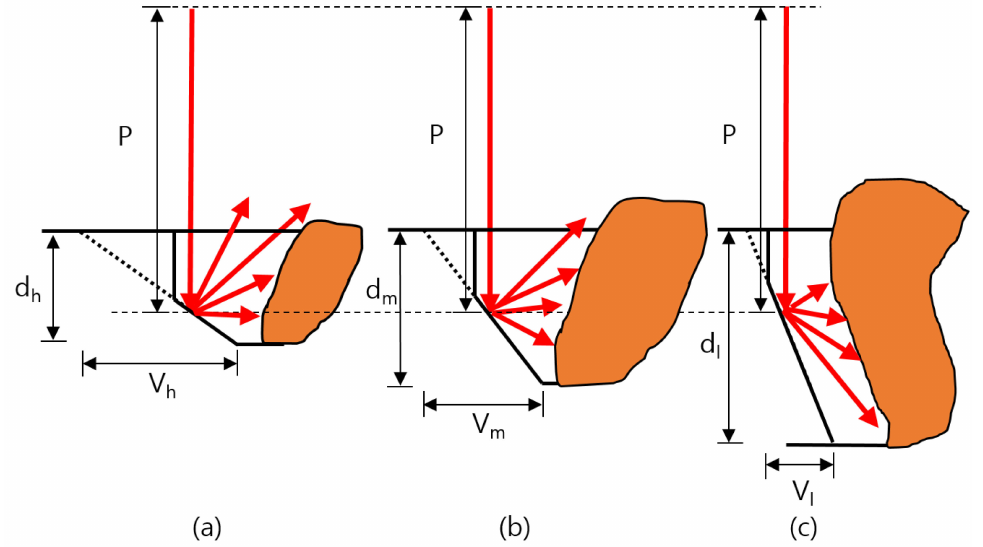
Figure 5. Keyhole formation at different welding speeds. The welding speed are represented by ( a ) V h , ( b ) V m , and ( c ) V l , where V h > V m > V l